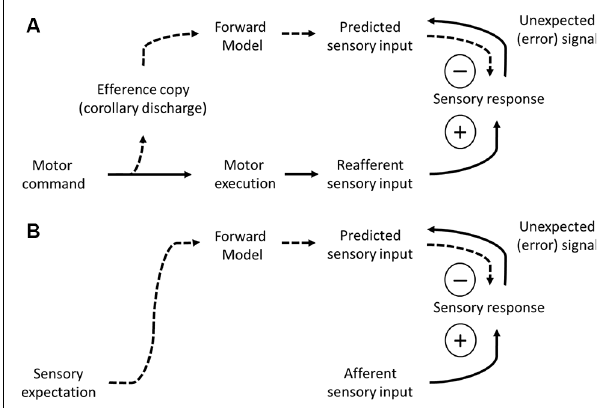
FIGURE 4 | Models of predictive coding. (A) A framework of predictive coding based on movement initiation. A motor command signal (bottom left) triggers motor execution (solid arrow) and sends a copy of the motor command to sensory cortices (efference copy or corollary discharge, dashed arrow). The forward model converts the motor command to a pattern of predicted sensory input. This predicted sensory input is subtracted from the feedforward sensory input, canceling out the reafferent (self-generated) component. Unexpected signals, not predicted by self-generated movement, are not subtracted and therefore propagate forward. Efference and prediction signals are carried by feedback pathways (dashes arrows) whereas sensory signals are carried by feedforward pathways (solid arrows). (B) A framework of predictive coding based on sensory expectation. Sensory expectation evokes signals reflecting the pattern of predicted sensory input, to subtract from afferent sensory input. Unexpected signals, not predicted by sensory expectation, are not subtracted and therefore propagate forward. Prediction signals are carried by feedback pathways (dashes arrows) whereas sensory signals are carried by feedforward pathways (solid